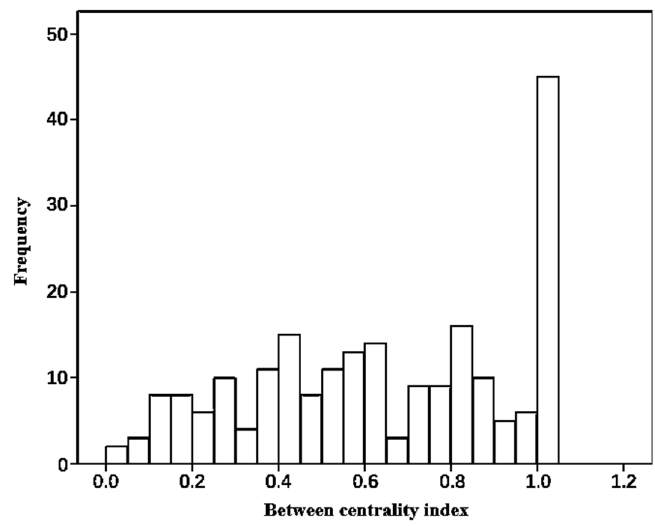
Figure 5. Frequency distribution of the between centrality index.